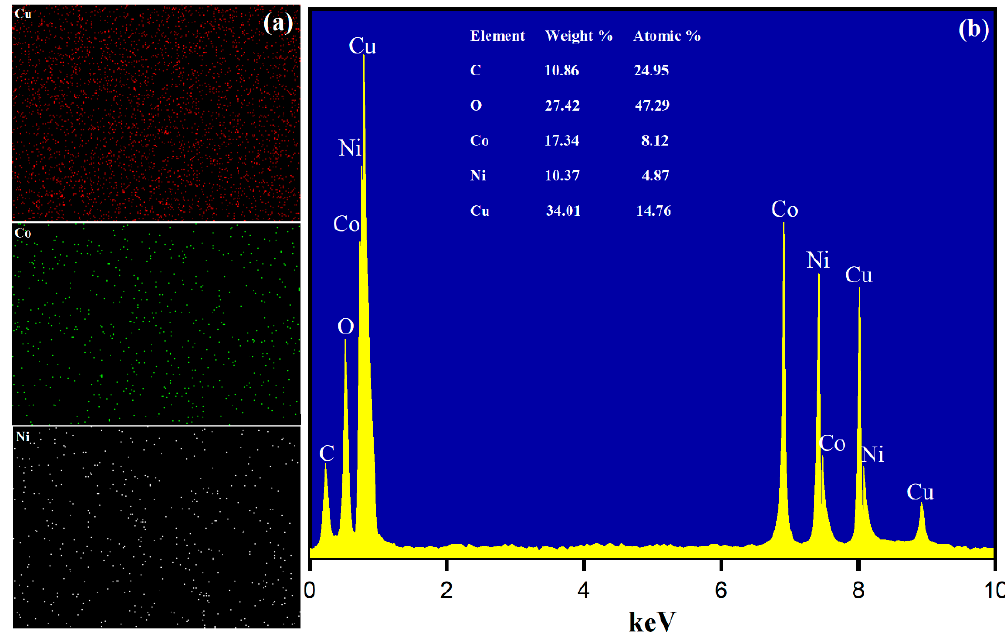
Figure 6. Energy-dispersive X-ray (EDX) elemental mapping of Cu-Co-Ni trimetallic nanoparticles ( a ) and EDX spectrum of biosynthesized Cu-Co-Ni trimetallic nanoparticles ( b ).